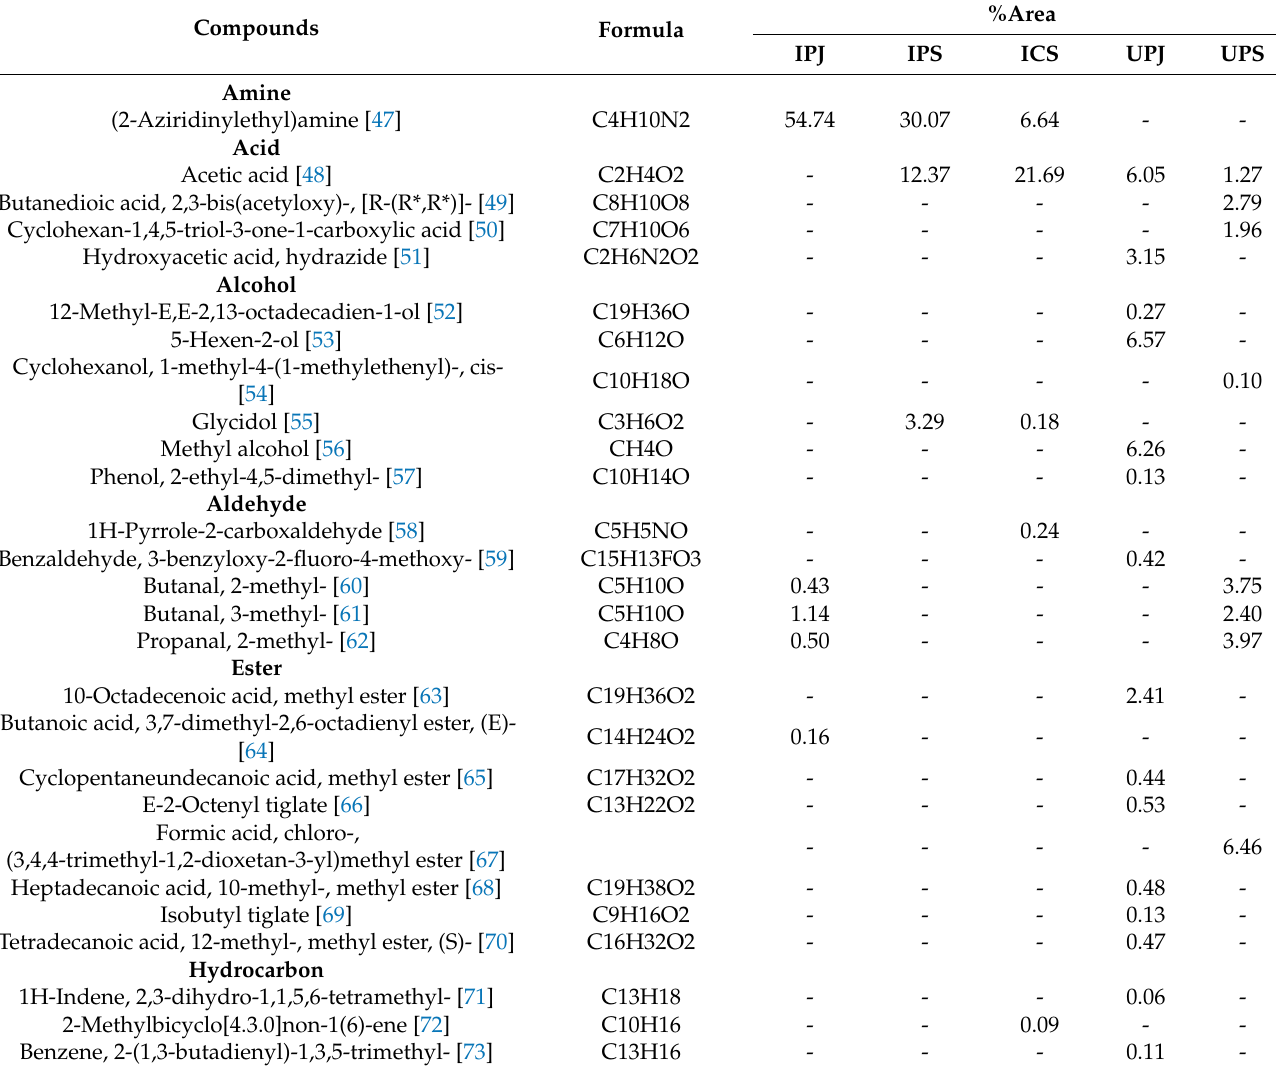
Table 1. Compounds emitted by pepper yellow leaf curl virus (PYLCV)-infected and PYLCV-undetected chili plants determined by gas chromatography-mass spectrometry